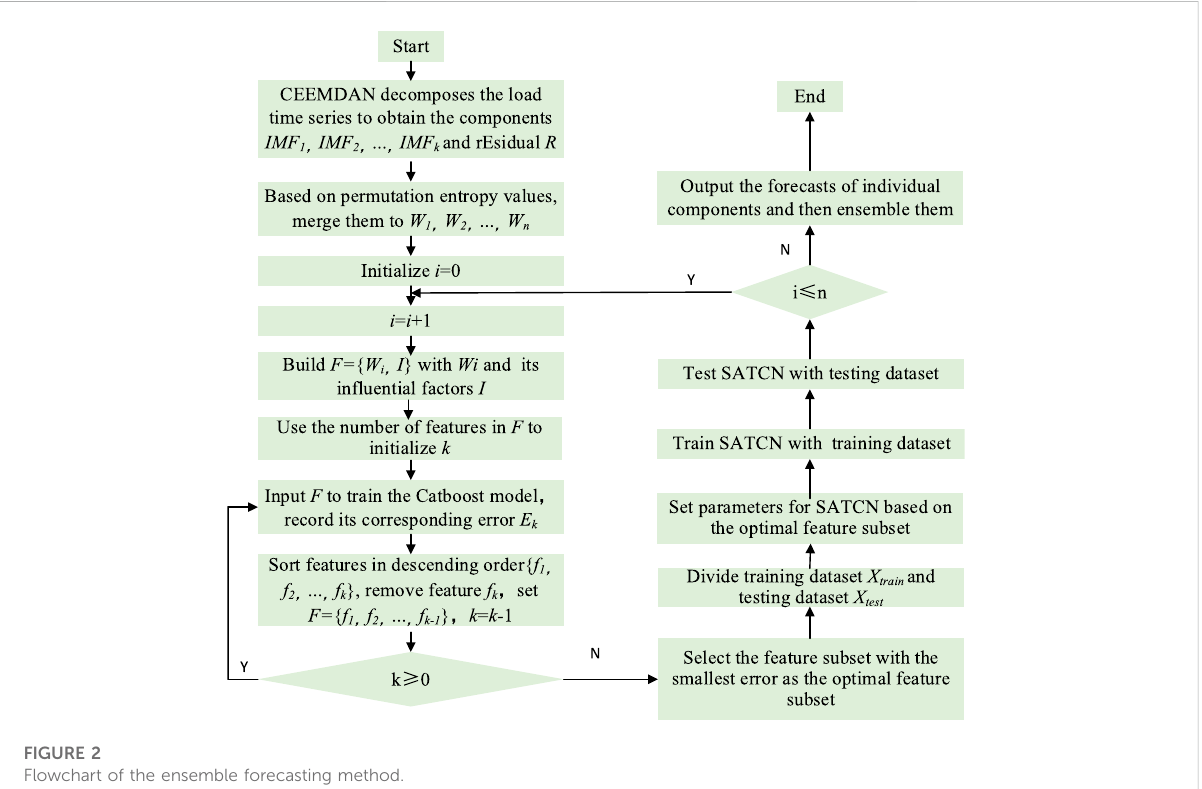
FIGURE 2 Flowchart of the ensemble forecasting